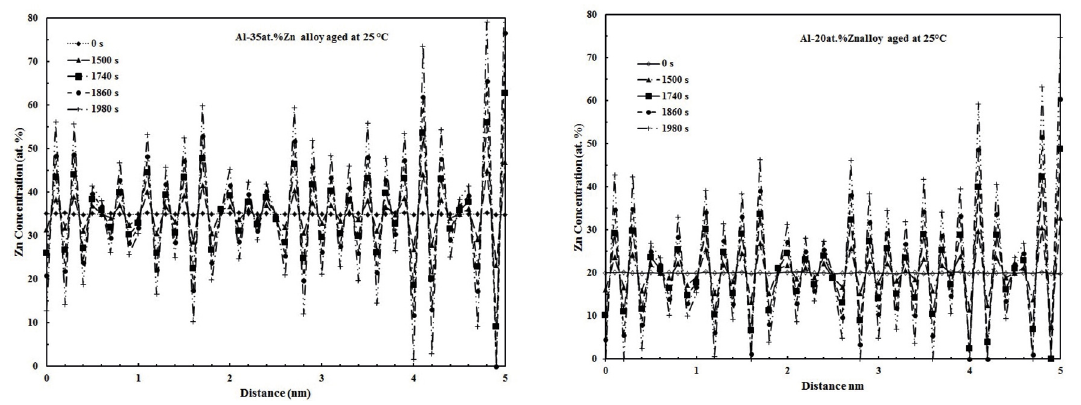
Figure 3. Zn concentration profiles of the Al-35at.%Zn alloy aged at 25 °C for different times. expected to occur in the spinodal decomposition mechanism.